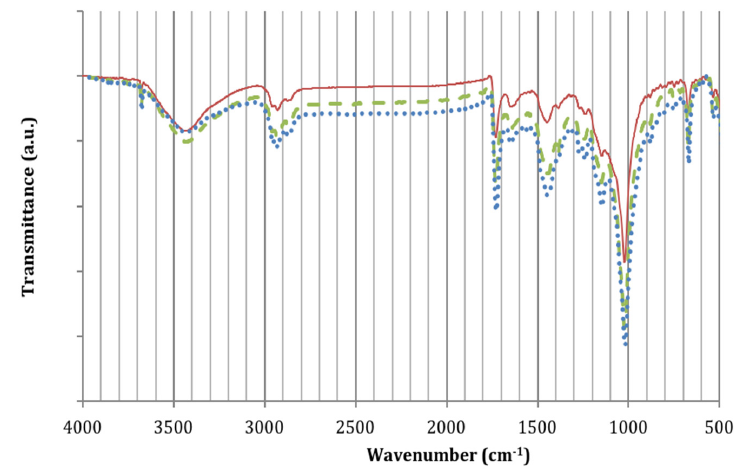
Figure 6. Infrared spectra (4000–400 cm − 1 ) of non ‐ metallic (black) graffiti on biocalcarenite after accelerated ageing induced by freeze ‐ thawing cycles. The dotted blue line of the spectrum corresponds to the beginning of the treatment, the dashed grey line to the 10th cycle and the continuous orange line to the 20th cycle.